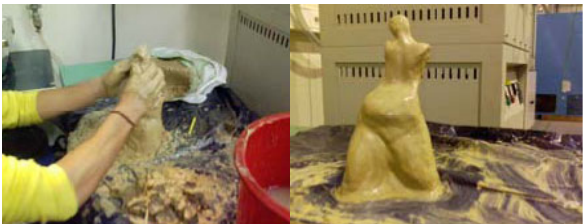
Figure 4. Clay sculpture.